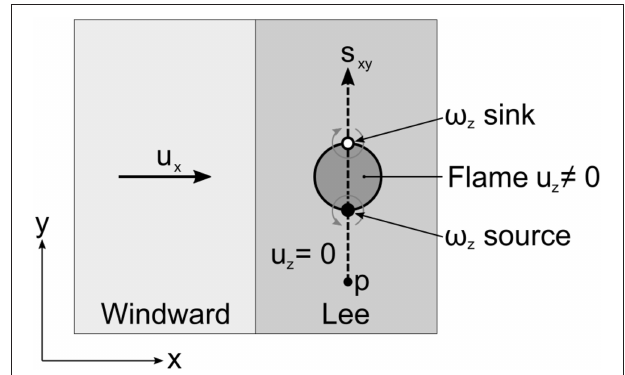
FIGURE 6 | Resultant vorticity in the z direction and circulation in the x - y plane from an idealized